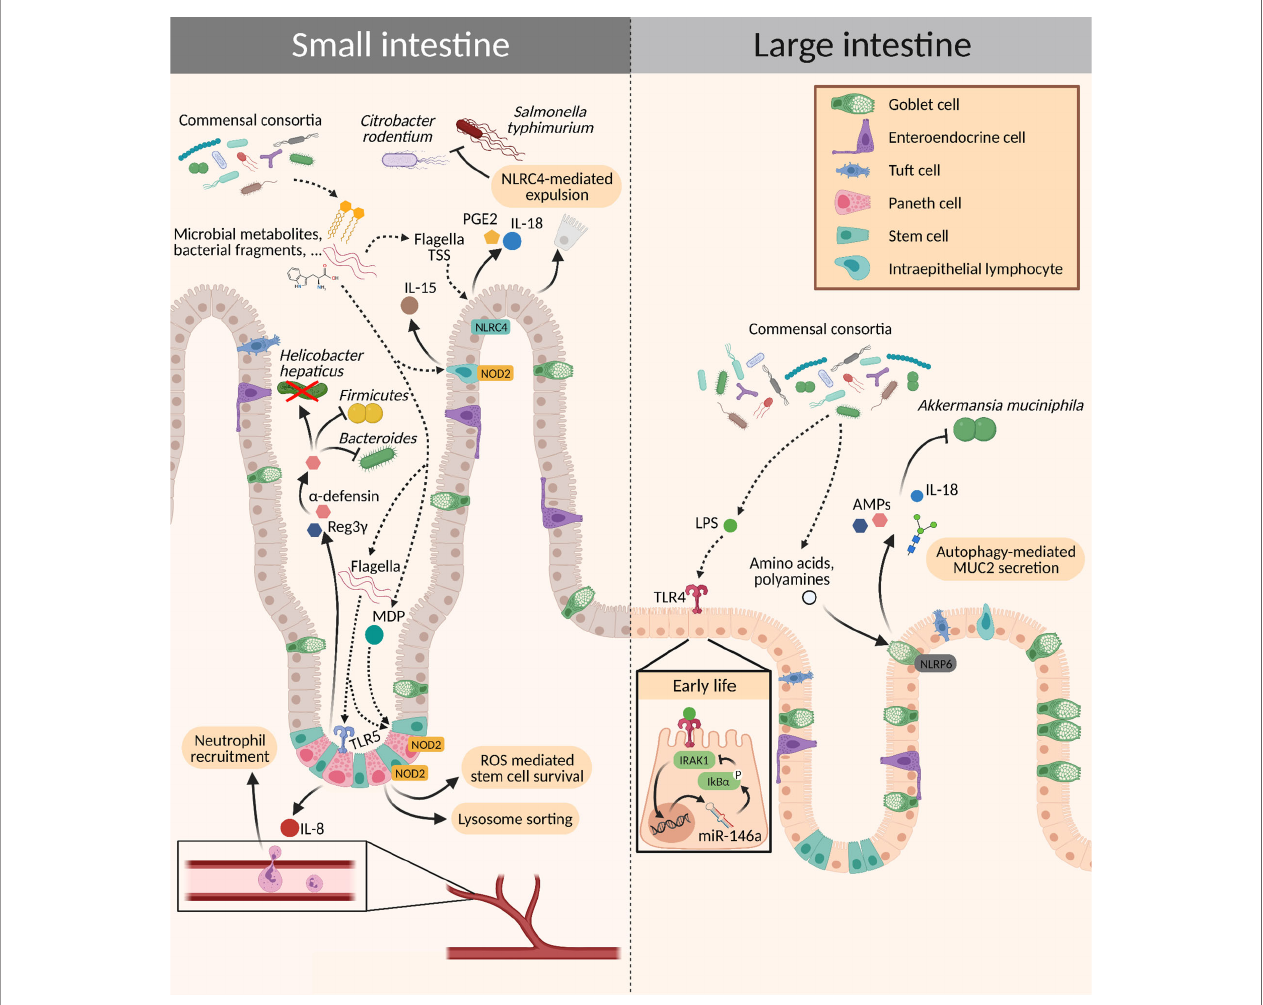
FIGURE 3 | Crosstalk between the microbiota and intestinal epithelial cells. Different signaling molecules from the microbiota bind to PRRs expressed on the epithelium, which subsequently activate innate immune mechanisms. This activation can elicit a wide range of effects: It may trigger a pro-in fl ammatory state for the elimination of pathogens or induce tolerance to commensals by increasing the production of mucins and AMPs, promoting epithelial cell turnover, and mediating stem cell survival. AMPs, antimicrobial peptides; MDP, muramyl dipeptide; PGE2, prostaglandin E2; ROS, reactive oxygen species; TSS, type secretion